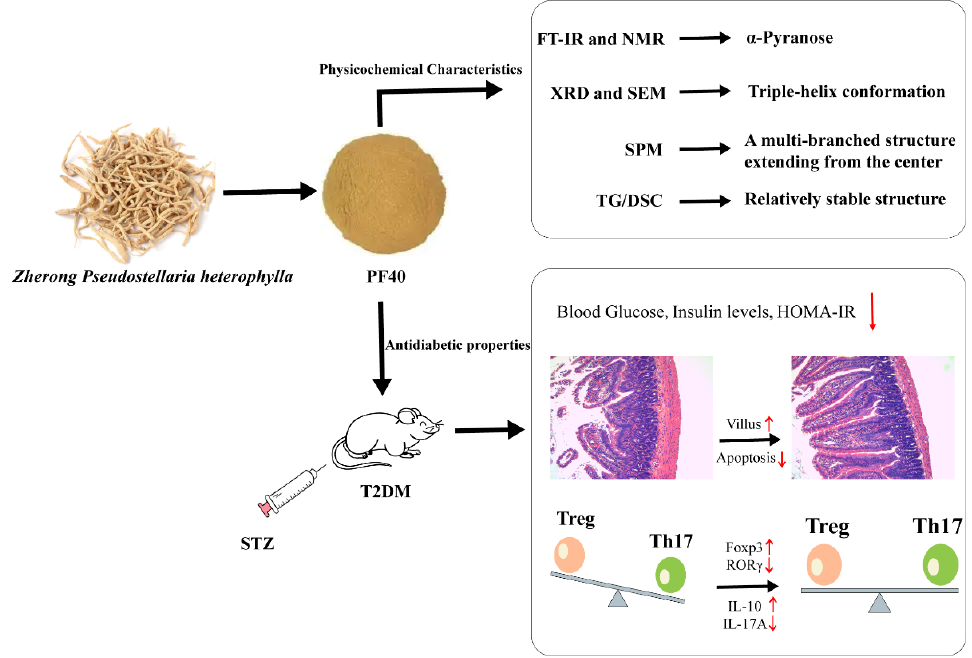
Figure 1. Diagram of the focus of this paper.